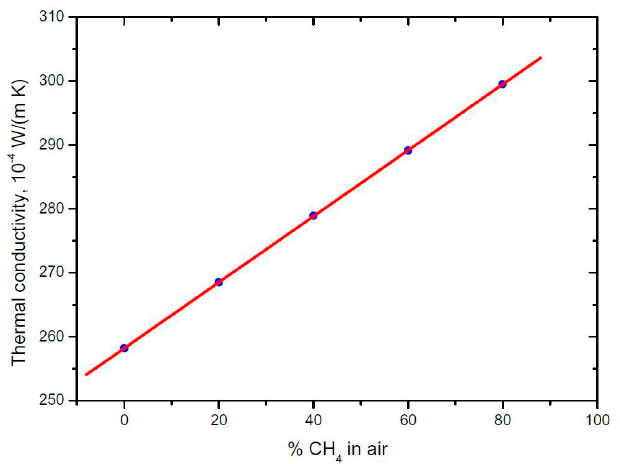
Figure 1. Thermal conductivity of mixture of methane with air at room temperature as a function of methane concentration in the mixture.